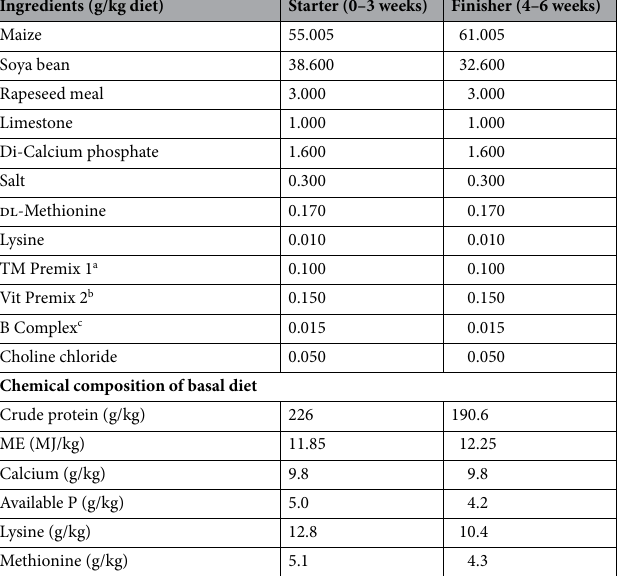
Table 1. Ingredient and chemical composition of basal feed. a TM premix (mg/kg) diet: MgSO 4 ·5H 2 O-300;